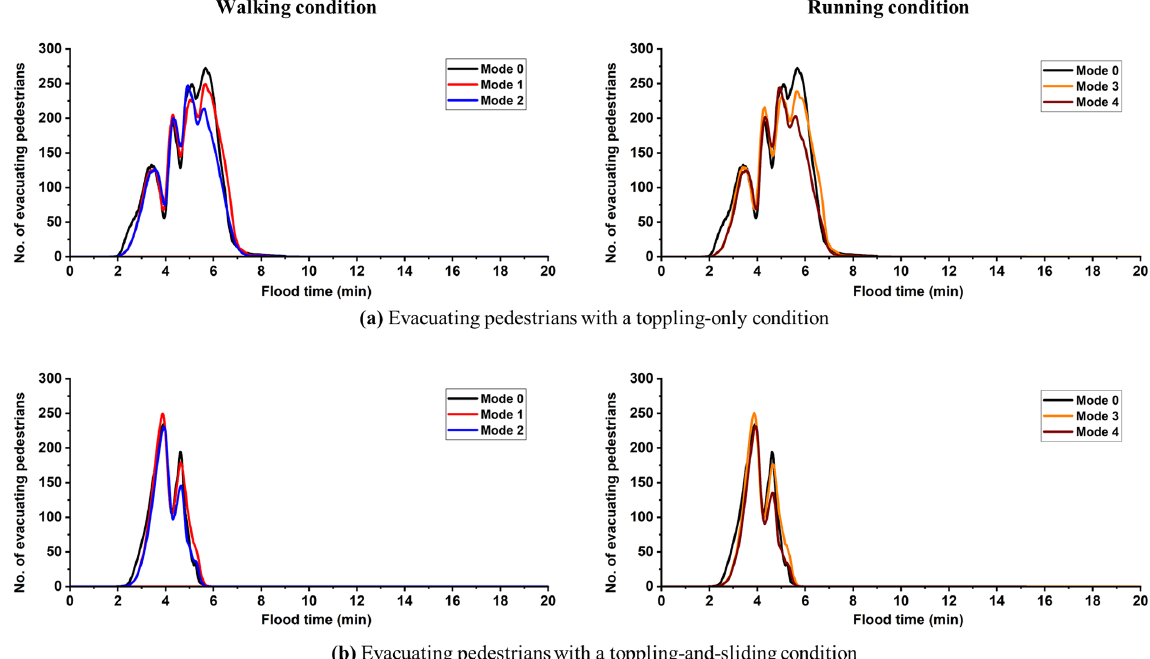
Figure 5. Number of evacuating pedestrians with different stability states predicted by the simulator after averaging the results from 20 runs under Mode 0 (baseline outcomes from the previous version of the simulator; Shirvani et al., 2020); Mode 1 or Mode 2 (age-related walking condition for the moving speeds without or with the two-way interaction condition); and Mode 3 and Mode 4 (age-related running condition for the moving speeds without or with the two-way interaction condition). Panels (a) and (b) include the stability states with a toppling-only condition and a toppling-and-sliding condition, respectively, when immobilised in